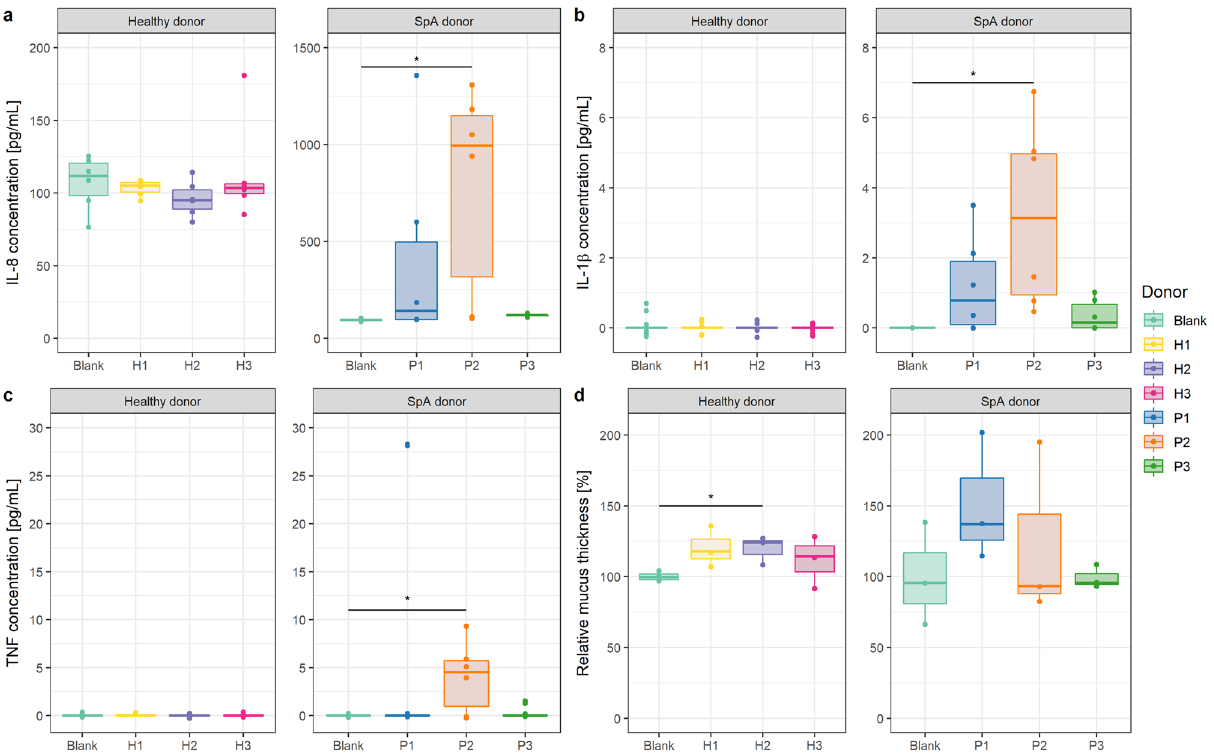
Figure 3. Triple cocultures coincubated with fecal microbiota from SpA patients respond in a more heterogeneous donor-dependent manner compared to healthy donors. Cytokine and mucus productions are benchmarked against the blank condition (not exposed to bacteria). ( a ) IL-8 concentration, y-axis displayed on a different scale for healthy and SpA donors (n = 6). ( b ) IL-1β concentration (n = 6). ( c ) TNF concentration (n = 6). ( d ) Relative MUC2 mucus production compared to the blank control condition, not exposed to bacteria (n = 3). *p <